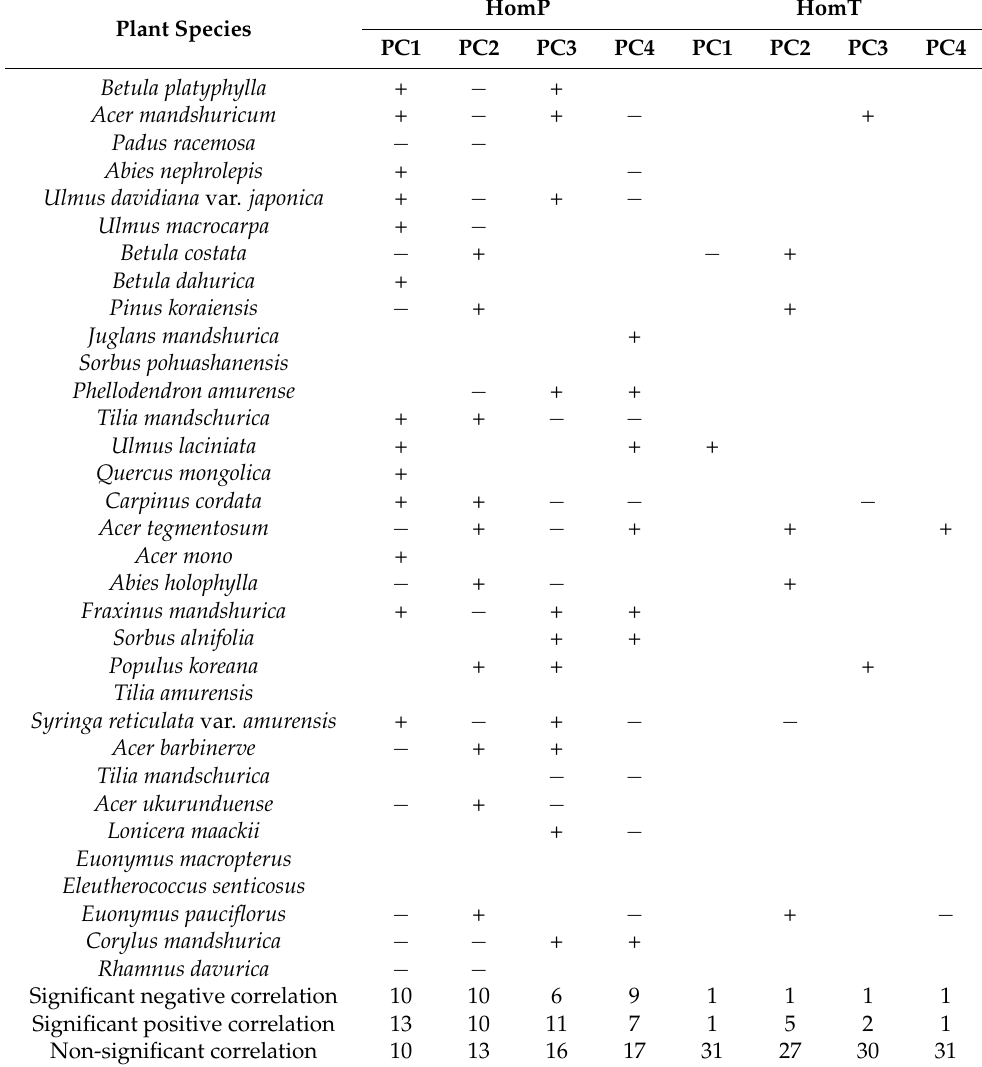
Table 4. Relationships between species distribution and one of the first four PC axes of soil elements in the lower soil layer. HomP represents the homogeneous Poisson process; HomT represents the homogeneous Thomas